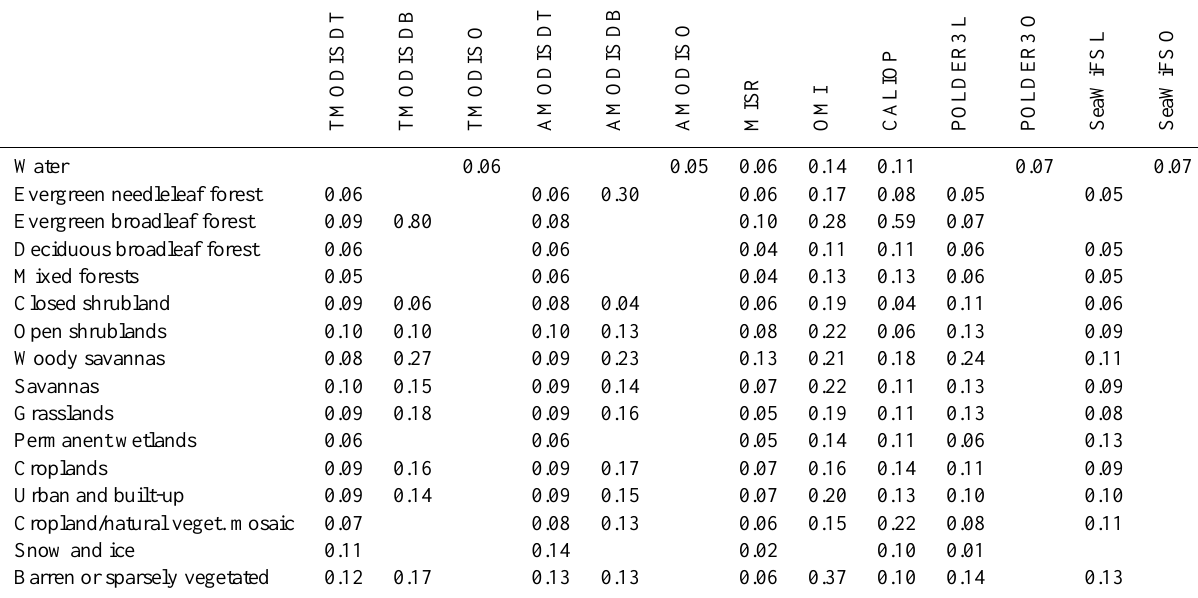
Table 5. Root mean square error (RMSE) between the collocated spaceborne and ground-based observations of AOD estimated at the stations that coincide with different IGBP land cover types. Empty cells indicate no collocated data available from a specific sensor over a specific land cover type. No AERONET stations are available at the areas occupied by deciduous needleleaf forest. The statistics were calculated based on the data that were pre-filtered by QA and screened of outliers as described in Sects. 4 and 5. A graphical representation of this table is in Fig. 14. Please see the Supplement for a breakdown of the listed statistics based on the nominal boreal